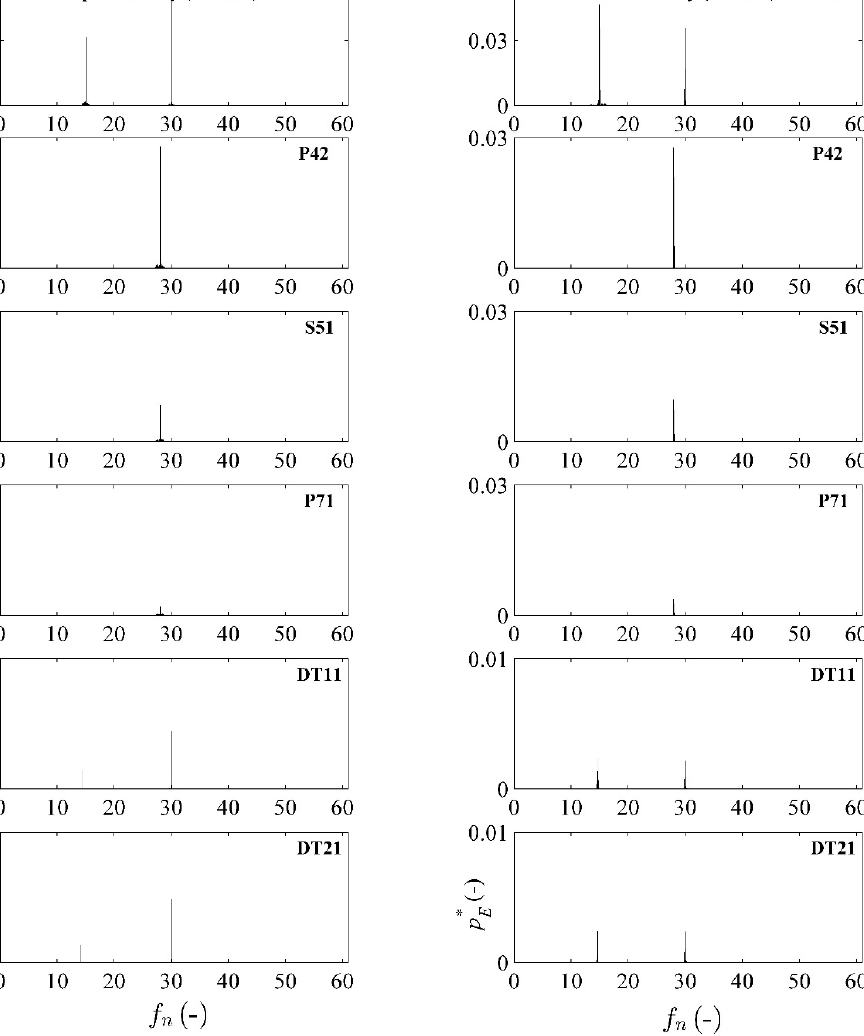
Figure 13. Frequency spectrum of experimental and numerical pressure-time signals in the vaneless space (VL01), runner (P42, S51 and P71) and draft tube (DT11 and DT21); the frequencies shown are normalized by a runner angular speed of 8.74 Hz; the dimensionless frequencies of 30 and 28 correspond to the blade passing and the guide vane passing frequencies, respectively.